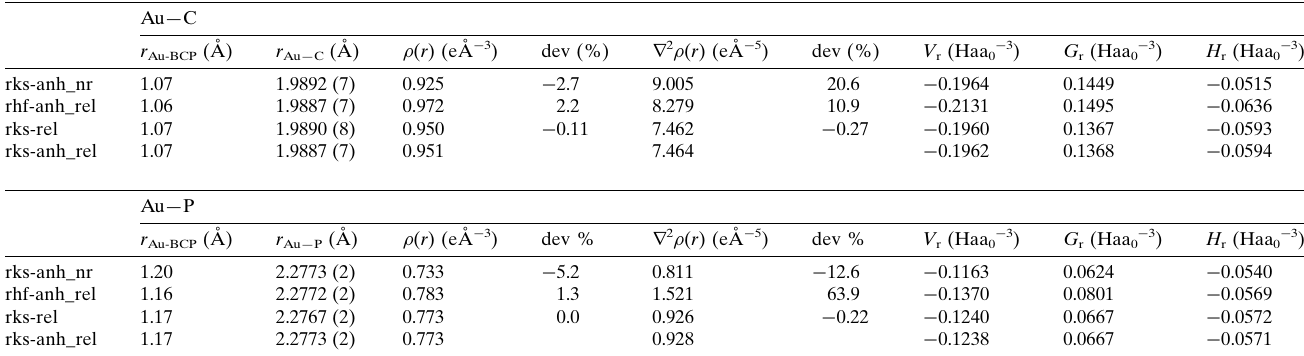
Table 5 Selected BCP topological properties of Au—C and Au—P bonds resulting from wavefunction analysis obtained with HARs for SP8 data. "dev" represents changes in the (cid:7) ( r ) and r 2 (cid:7) ( r ) values arising from REL, ECORR and ANH and are expressed in percentages relative to the rks-anh_rel values.